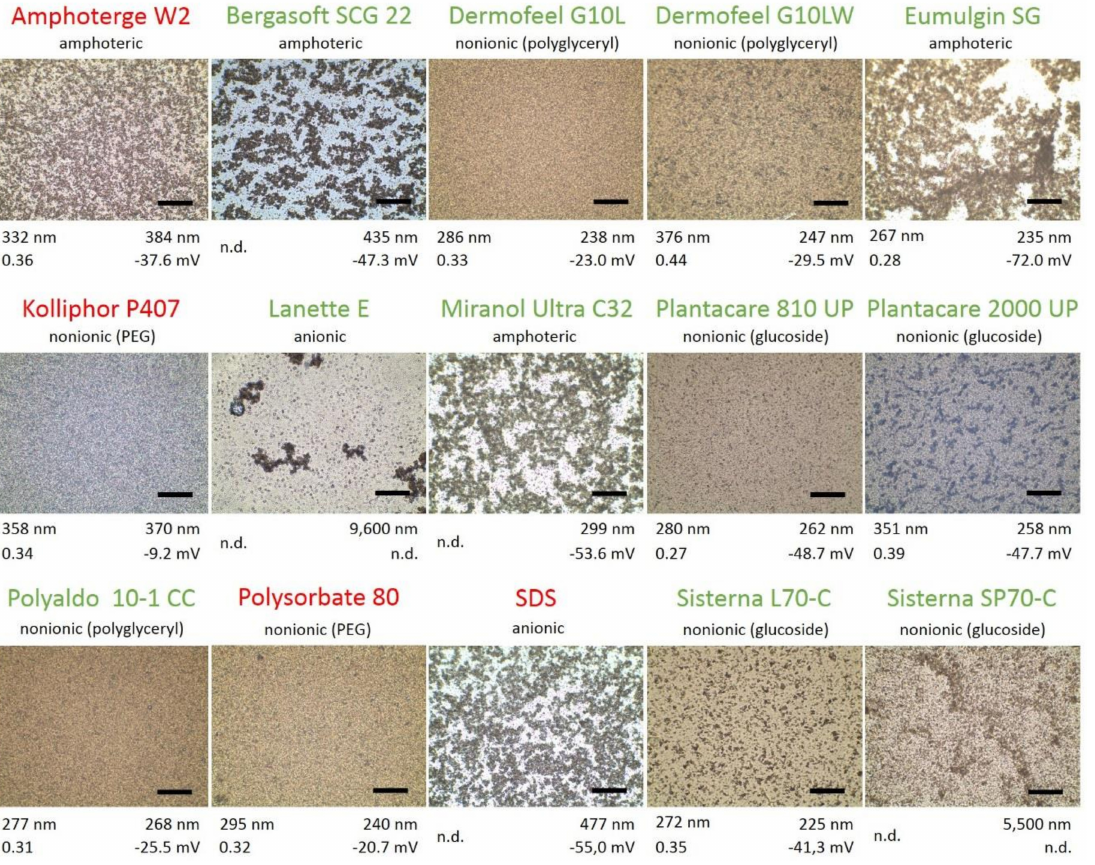
Figure 3. Microscopic images at 400-fold magnification (scale bar 50 µ m) for all produced samples with 2% surfactant, where ECOCERT surfactants are highlighted green and non-ECOCERT surfactants in red. The type of surfactant used is written above respective image, the z-average (z-ave) and polydispersity index (PdI) left under the image, and LD50% value and zeta potential right under the